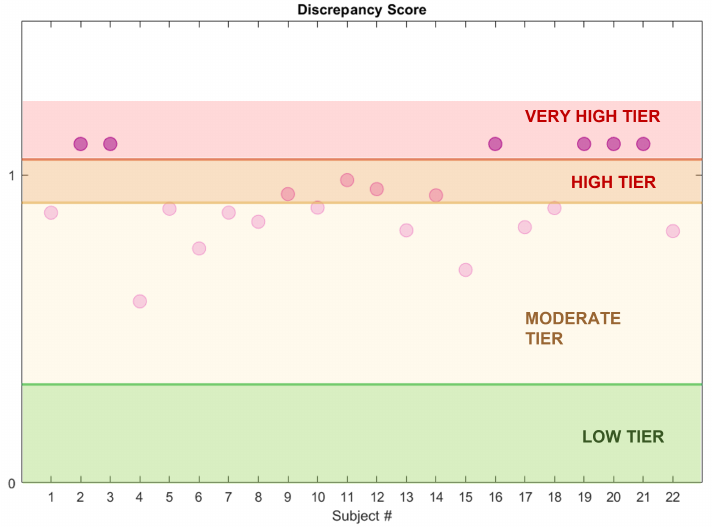
Figure 13. Dissociation Index and estimated impairment areas. The dots represent the subjects’ DI value (RBD cohort, CAP Sleep